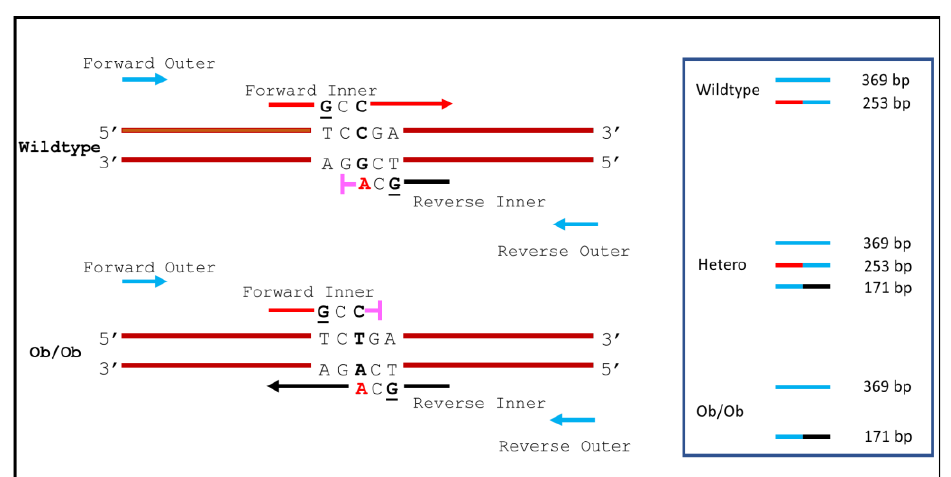
denaturation at 95 ◦ C for 30 s, annealing at 58 ◦ C for 30 s, and extension at 72 ◦ C for 1